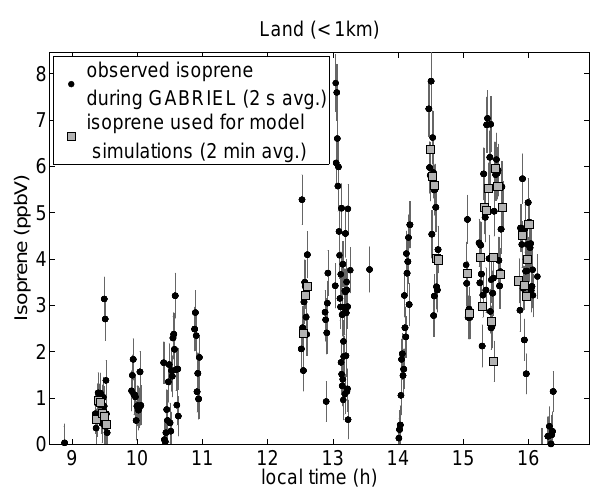
Fig. 11. Observed isoprene mixing ratios with their measurement uncertainties for altitudes < 1km over the rainforest.